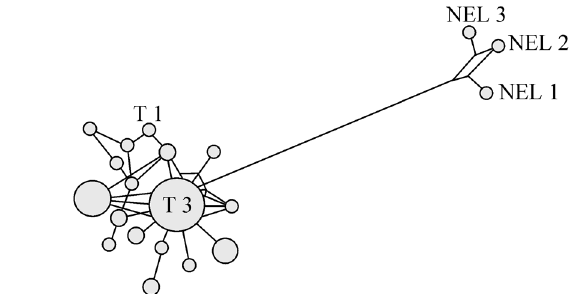
Figure 2 - Reduced median network relating mtDNA haplotypes detected in Brangus-Ibage and Nellore samples. The T1 and T3 reflects ancestral haplotypes of African B. p. taurus and European B. p. taurus as defined by Troy et al .